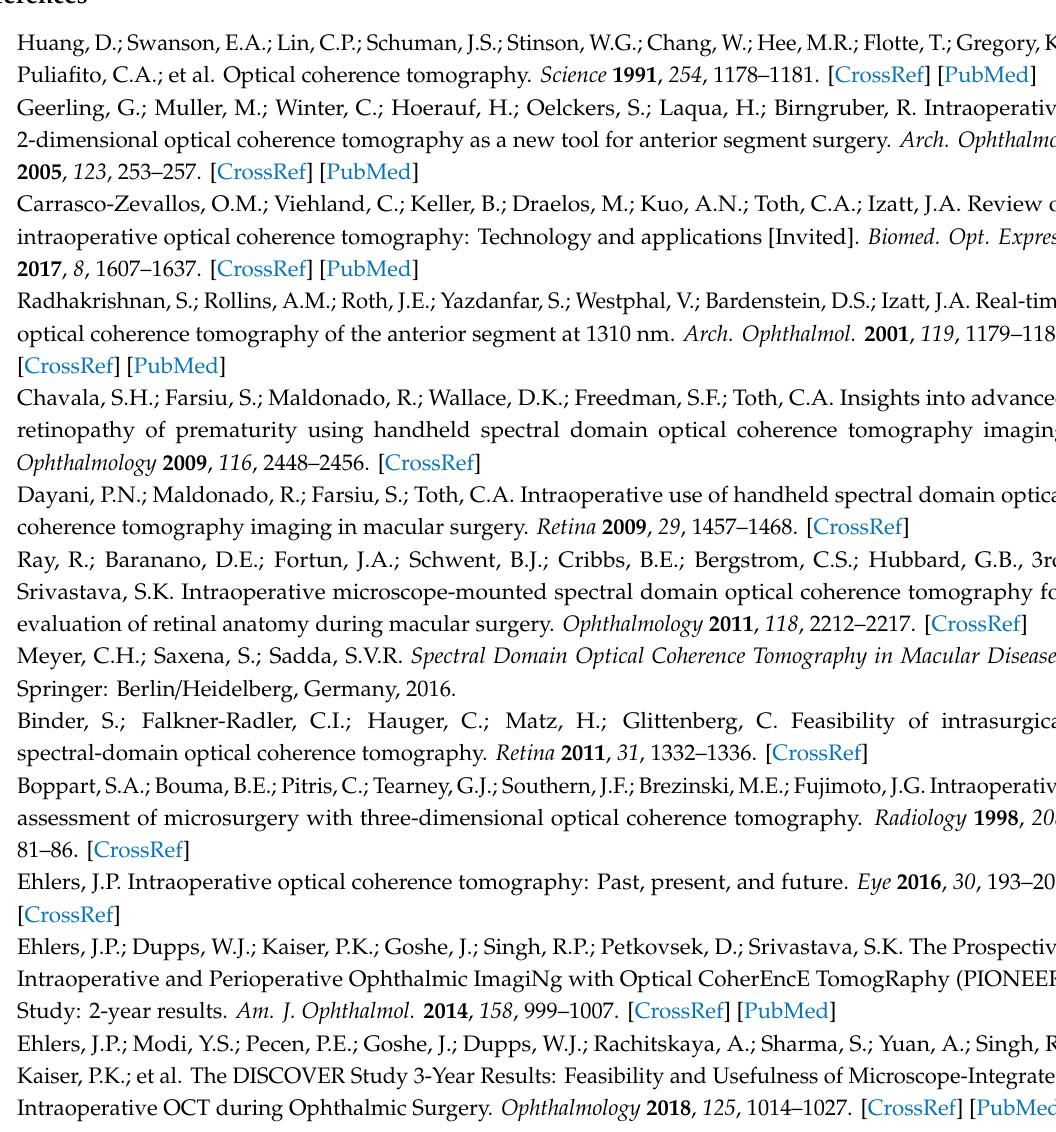
Table S1: Anterior segment studies included, Table S2: Posterior segment studies